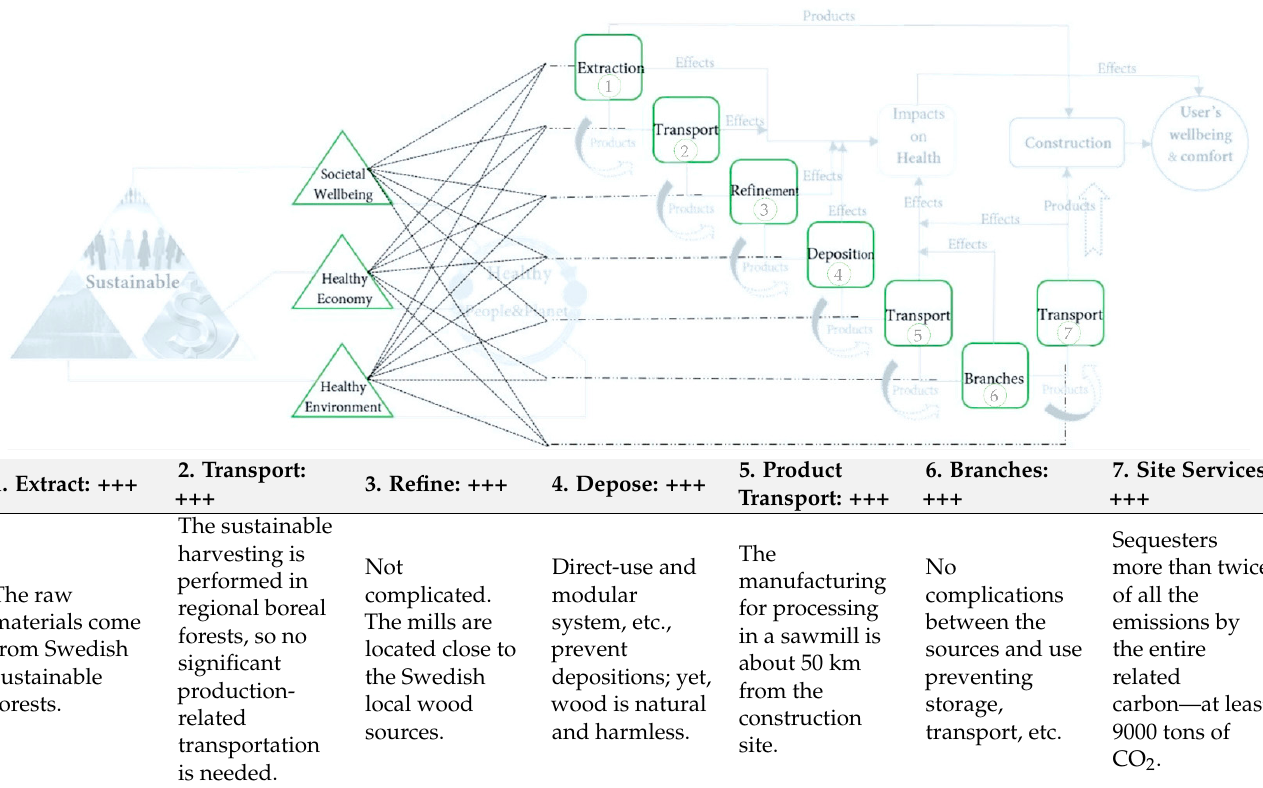
Table 8. Streamlining brief evaluation of CMs of Sara Cultural Centre with general items of PCMs.